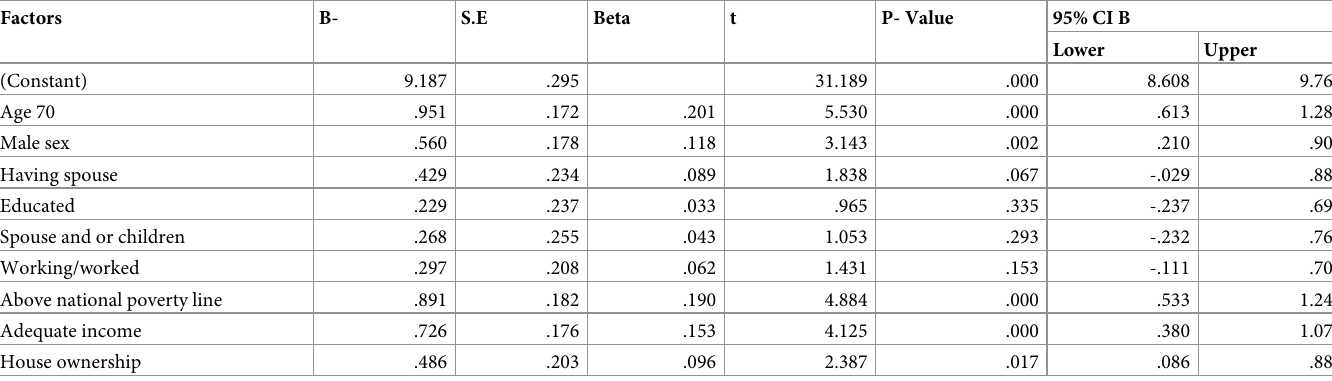
Table 3. Contributing factors of physical health domain of the QOL of participants.